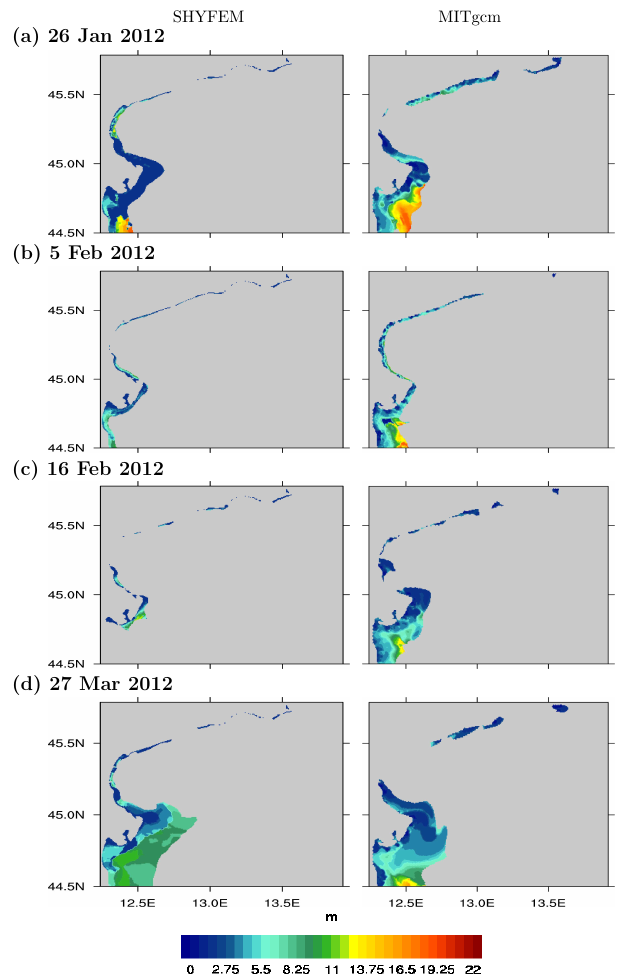
Figure 12. Maps of the depth at which the highest salinity gradient (freshwater above, saline waters below) occurs, within the 37psu isoline that identifies ROFI in the NAS, for the dates